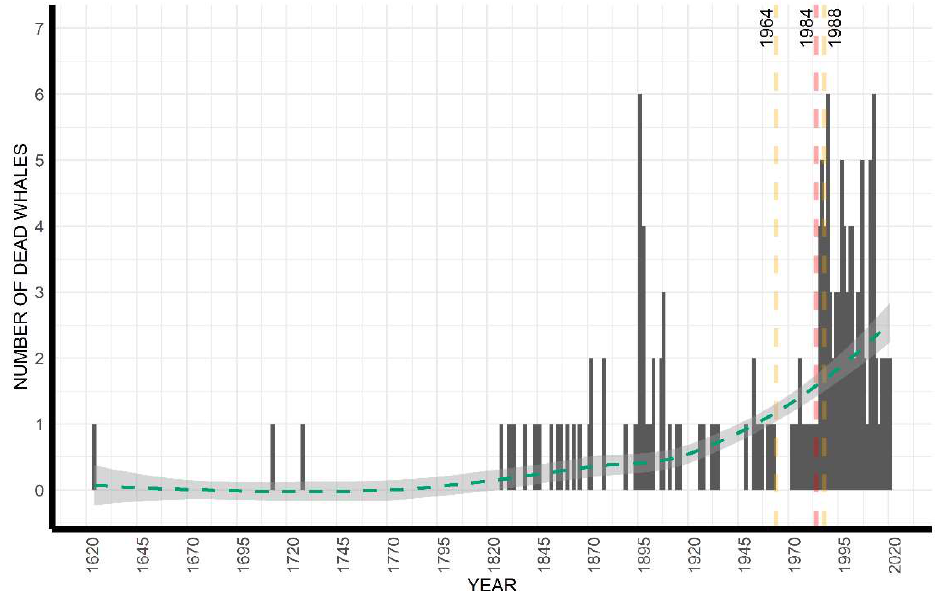
Figure 2. The total number of dead fin whales by year between 1624 and 2021. Although the years 1624, 1713, and 1728 were highlighted as outliers in the time series and not included in the formal analysis, they are shown here to depict the entire dataset. Dashed red lines represent the breakpoint in the time series and the dashed orange lines represent the breakpoint Lower and Upper Confidence Intervals.